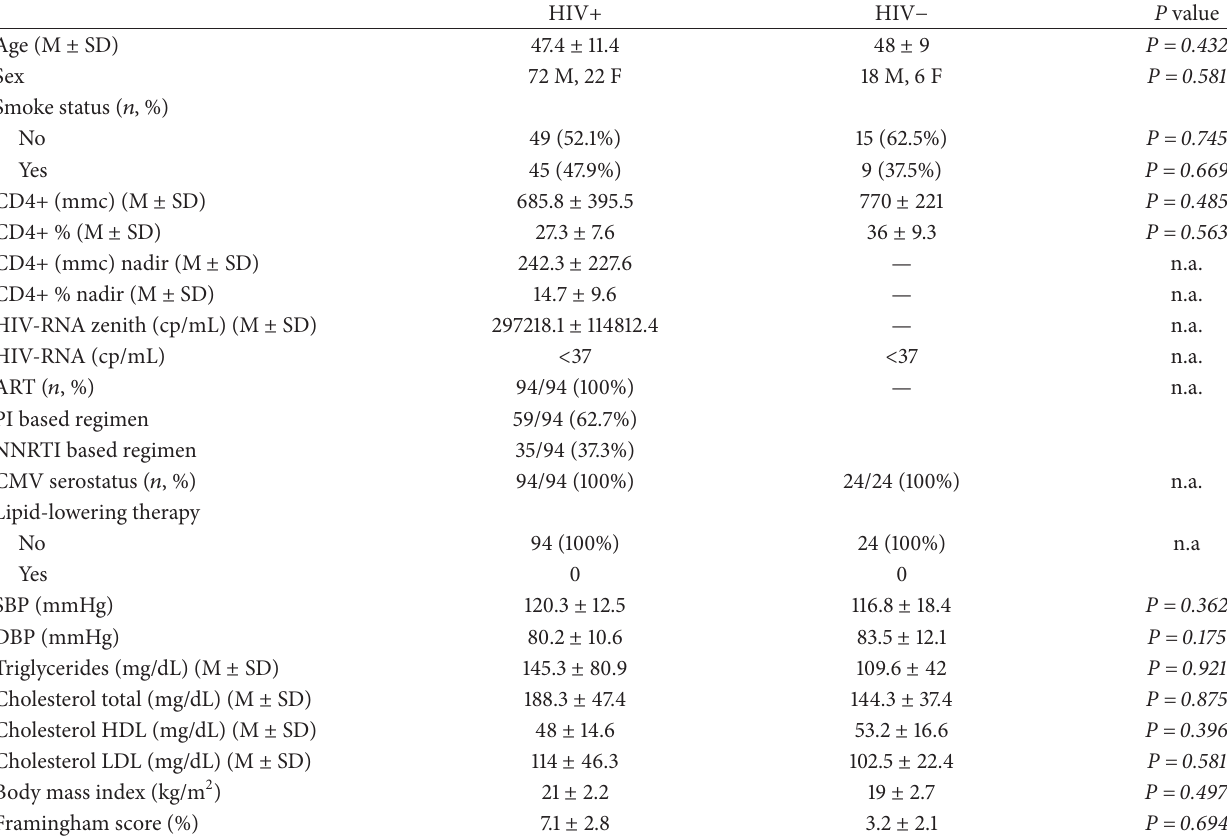
Table 1: Clinical characteristics of study